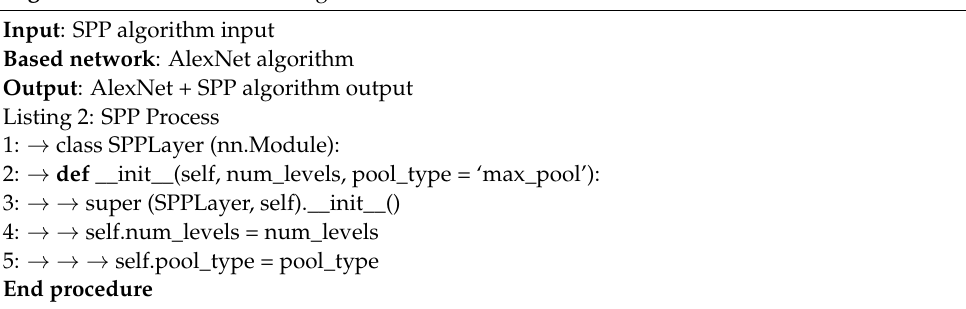
Figure 3. The model of AlexNet + SPP. Algorithm 2 : AlexNet + SPP Algorithm